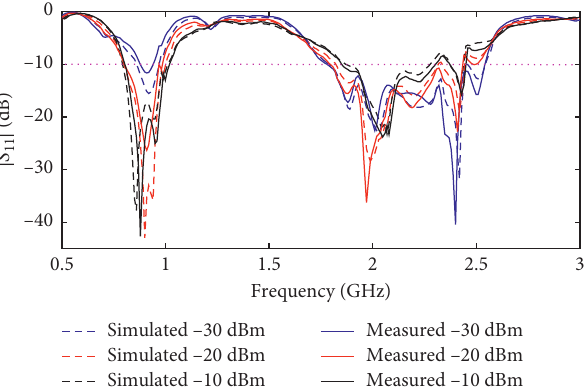
Figure 11: The measured and simulated | S rectifier for three input power levels for the load resistance of 4.7 k Ω .